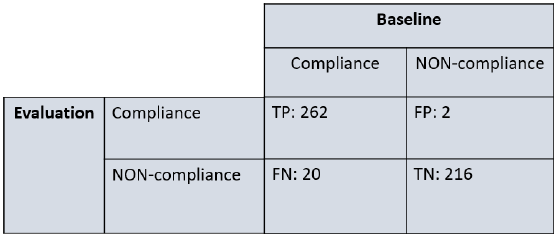
Figure 5. Effectiveness confusion matrix. Figure 5. E ff ectiveness confusion